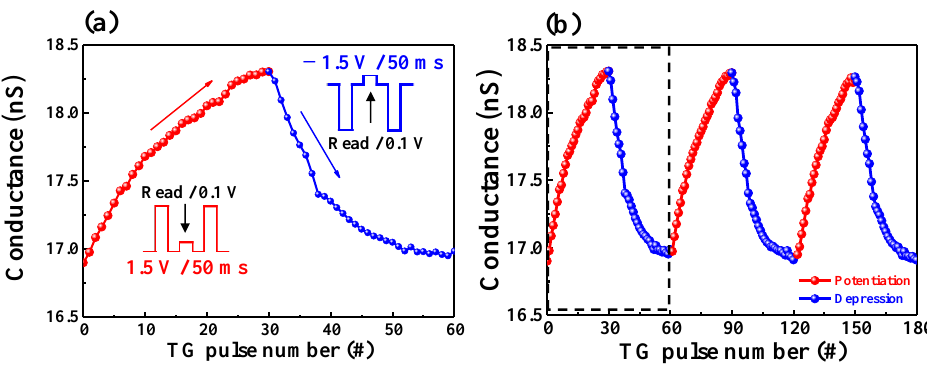
Figure 6. ( a ) Gradual conductance modulation by repeated synaptic potentiation (1.5 V for 50 ms) and depression ( − 1.5 V for 50 ms) pulses; ( b ) three cycles of repetitive conductance modulation.